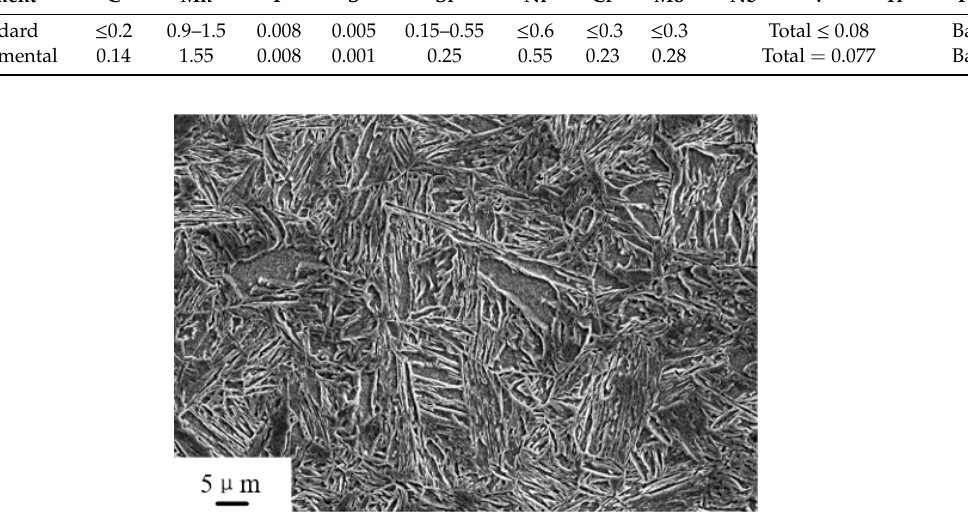
Figure 1. SEM image of as-quenched SA738 Gr.B steel.